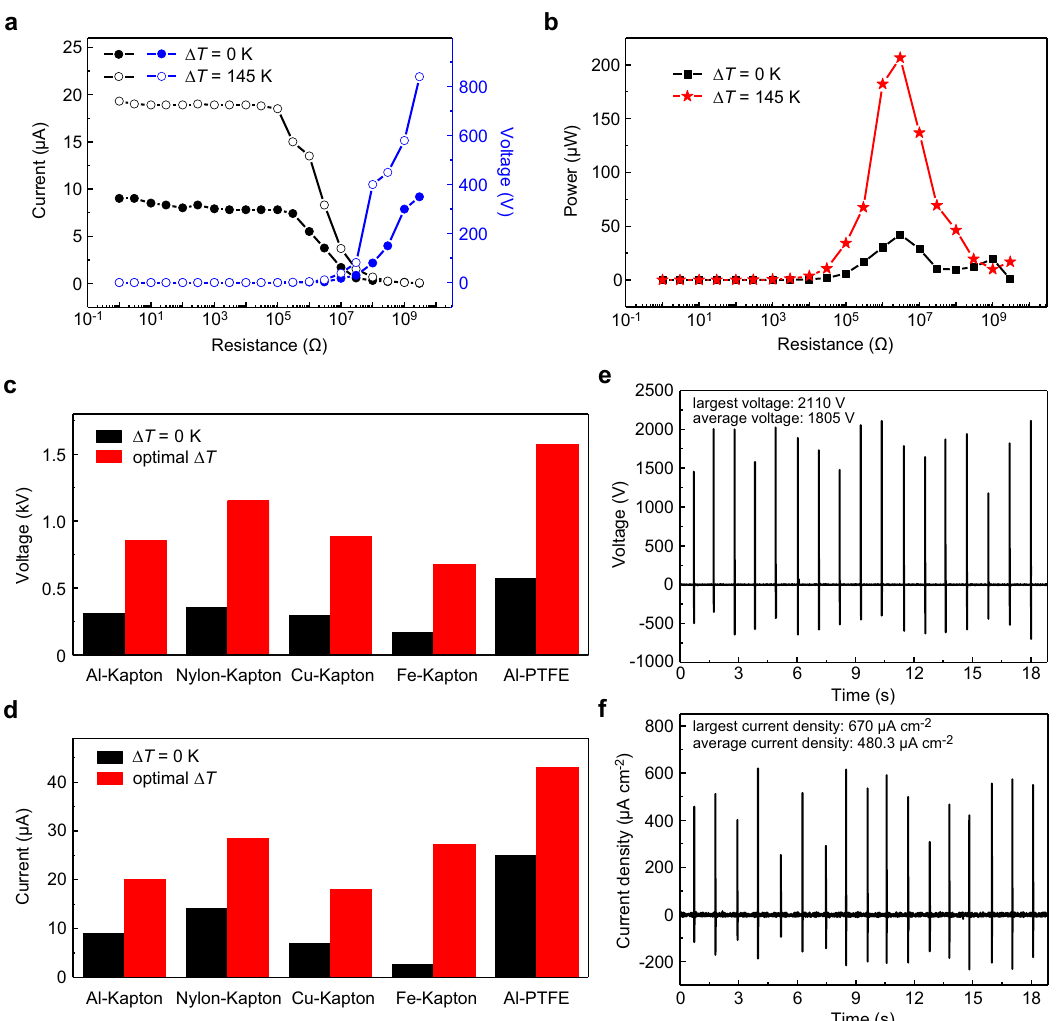
Fig. 4 The in fl uence of Δ T on TDNG with different friction materials. a The output voltage (blue line), current (black line) of TDNG with different external circuit load resistance when Δ T is equal to 0 K and 145 K, respectively. b The output power of TDNG with different external circuit load resistance when Δ T is equal to 0 K (black line) and 145 K (red line), respectively. c The open-circuit voltage and d short-circuit current with different friction materials when Δ T = 0 K (black column) and optimal Δ T (red column). e The open-circuit voltage and f short-circuit current density of Al-PTFE TDNG at Δ T = 90 K.